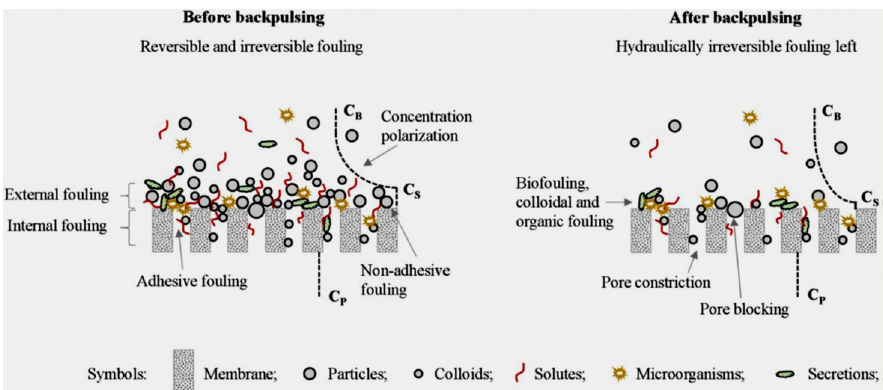
Figure 13. Depicts an overview of the membrane prior to and after backpulsing in MF and UF processes, where C B , C S , and C P are the concentrations of solutes in the bulk, near the membrane surface, and permeate, respectively [97].